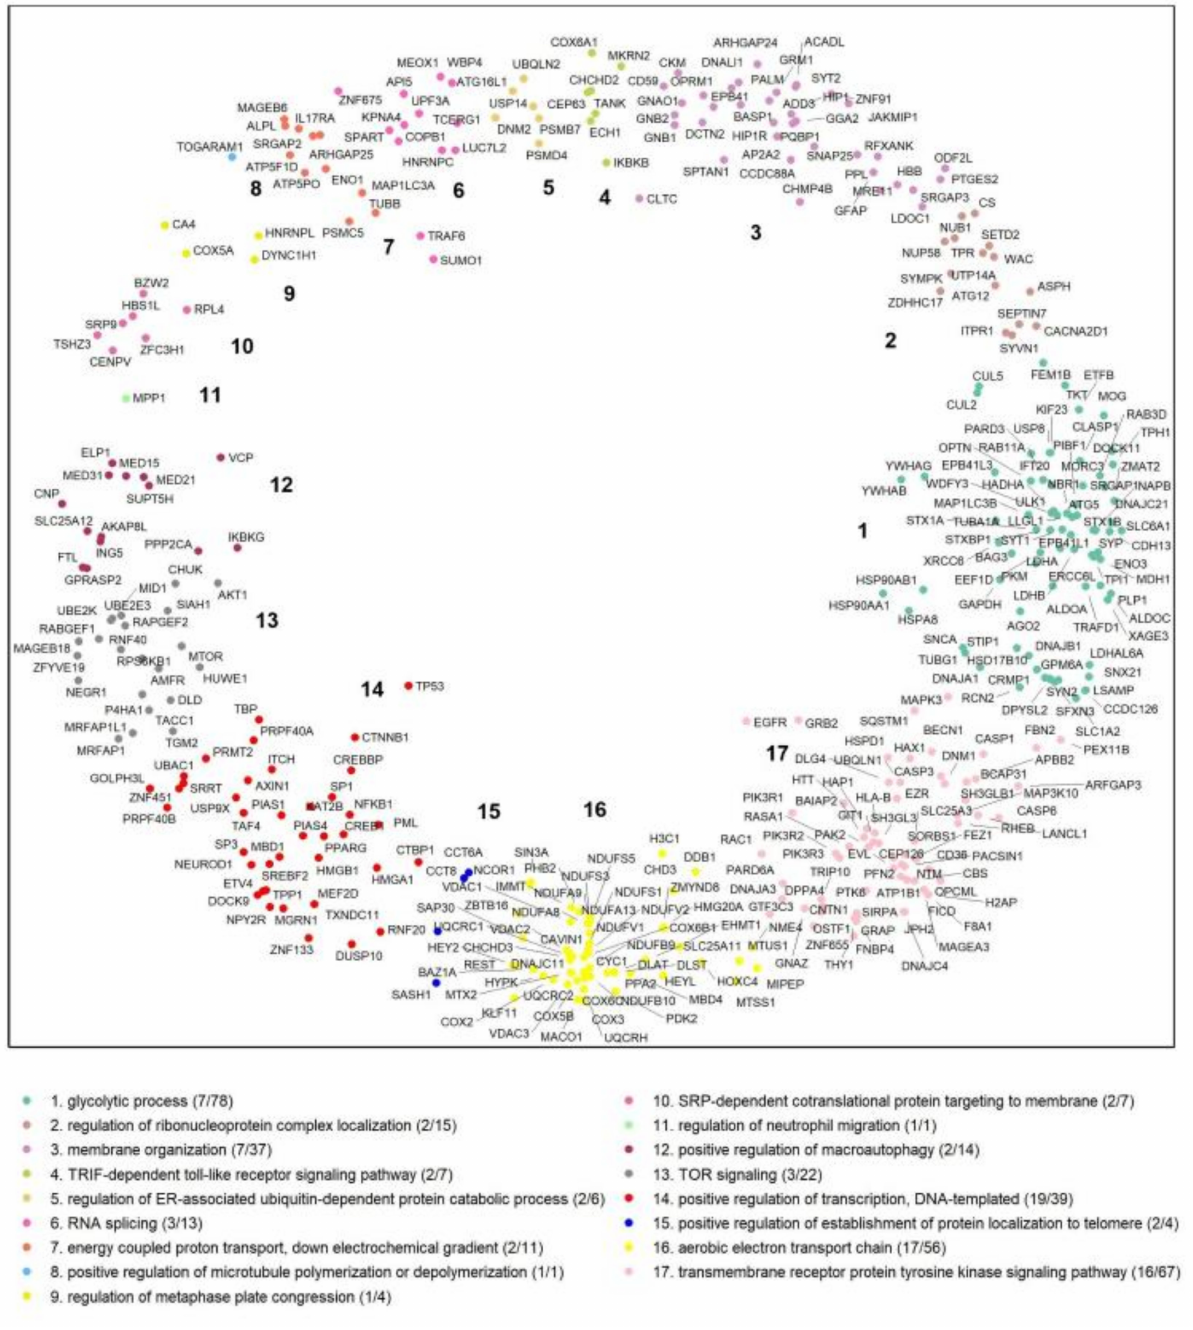
Figure 2. HTT interactors in the H 2 . The different clusters were identified by big gaps separating groups of proteins in the angular dimension of the hyperbolic space. Each cluster was assigned a numeric identifier (1–17). The number of proteins/genes that are associated with the GO BP terms and the number of proteins/genes in each cluster are